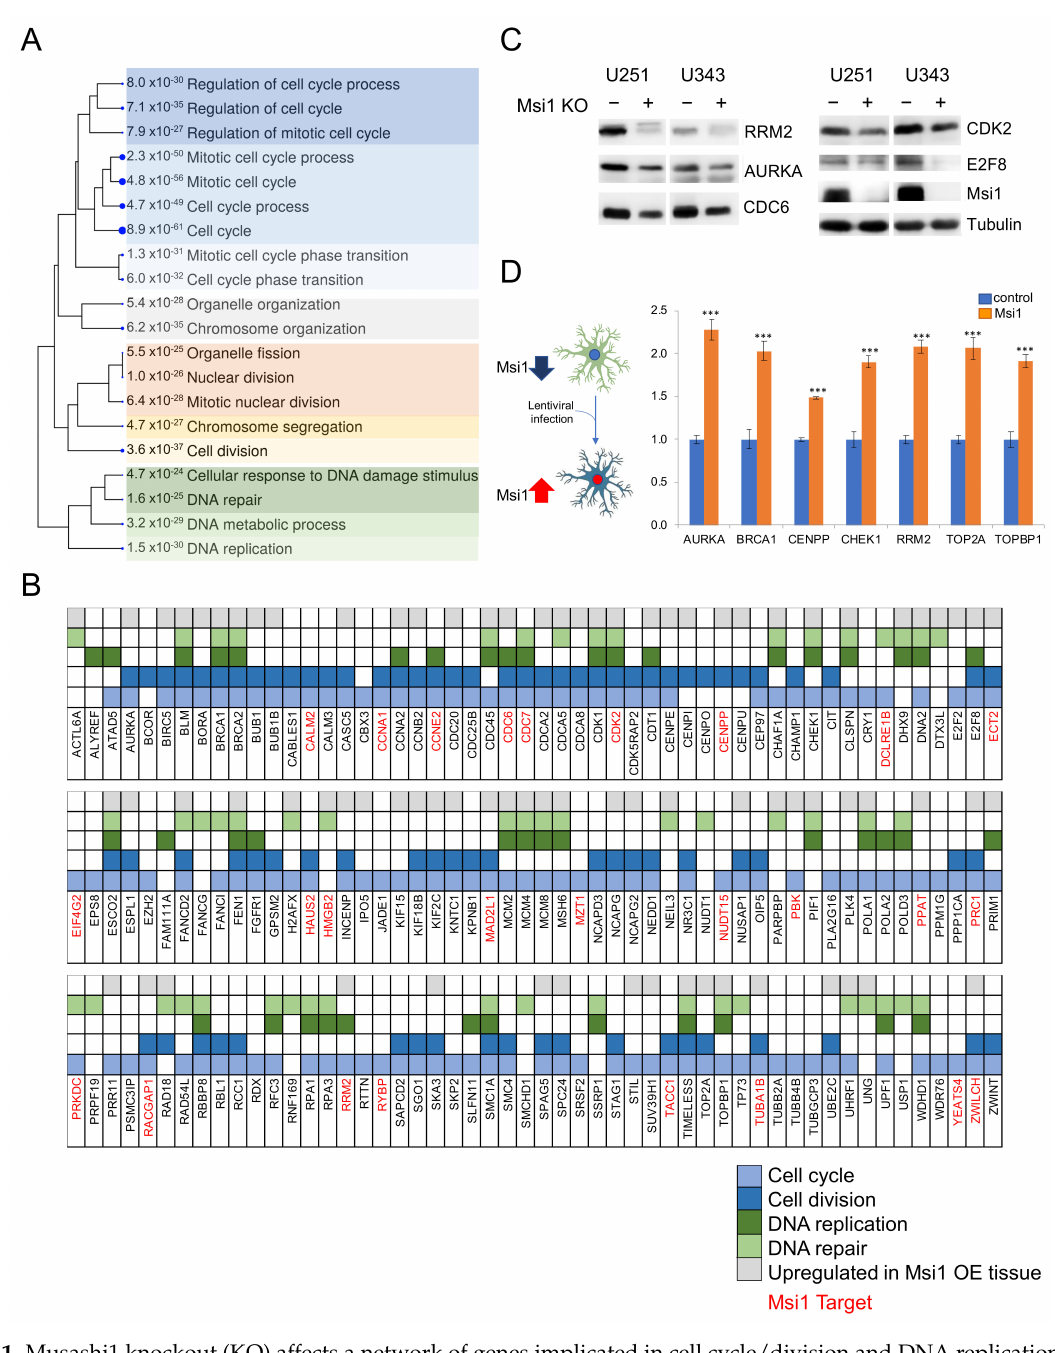
Figure 1. Musashi1 knockout (KO) affects a network of genes implicated in cell cycle/division and DNA replication/repair. ( A ) The diagram shows the Gene Ontology terms (biological processes) enriched among genes downregulated in both U251 and U343 Msi1 KO lines in comparison to respective controls, according to ShinyGo [27]. ( B ) Tables show downregulated genes in both U251 and U343 Msi1 KO lines and their functions. Gray boxes indicate the genes from this group that showed increased expression in a transgenic mouse line displaying Msi1 overexpression (OE) [21]. Msi1 targets previously identified by CLIP (Crosslinking and Immuno-precipitation) or RIP (Ribonuclear particle immuno-precipitation) [3,9,23] are labeled in red. ( C ) Western analysis of cell cycle and DNA replication genes affected by Msi1 KO in both glioblastoma (GBM) cell lines U251 and U343. The uncropped Western blots have been shown in Figure S4. ( D ) qRT-PCR analysis shows that transgenic expression of Msi1 in astrocytes increased the expression of cell cycle and DNA replication genes. Statistical significance calculated by multiple t-test. Data shown as means ± s.d. *** p <